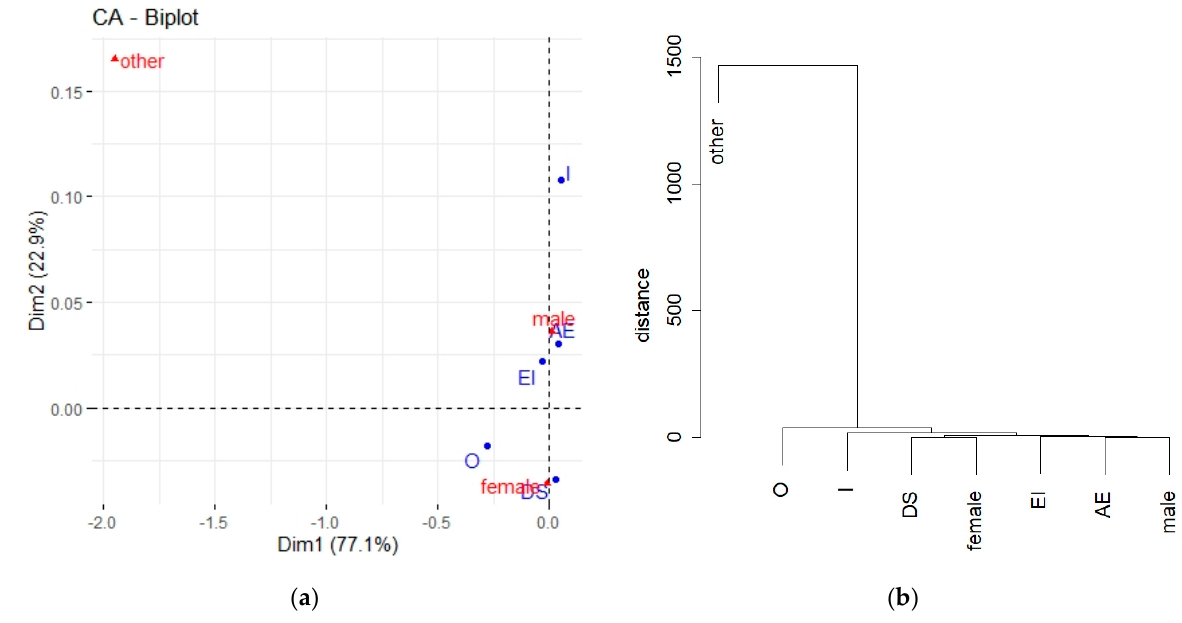
Figure 8. Correspondence map ( a ) and an auxiliary dendrogram ( b ) showing the dependence of each behavioural type of energy consumer on their gender.